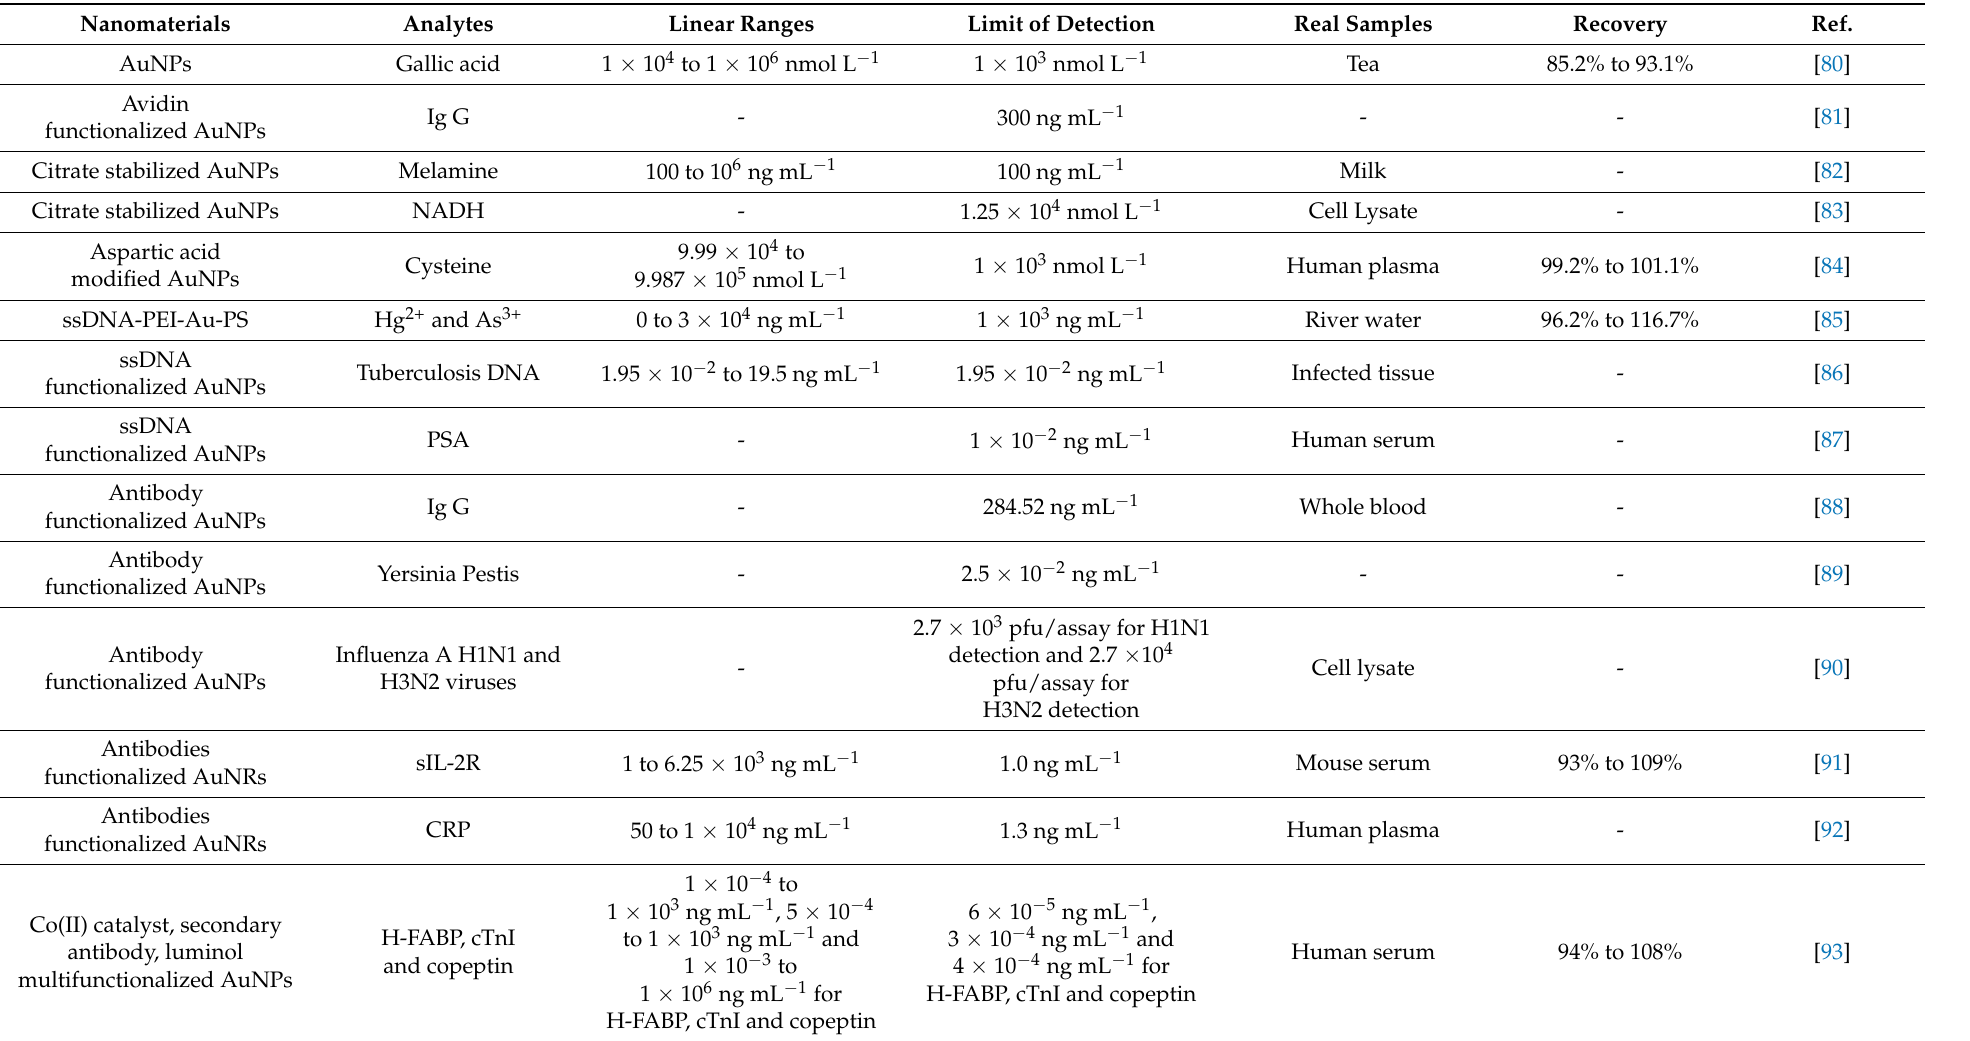
Table 2. The typical nanomaterial-enhanced colorimetric PADs for sensing various